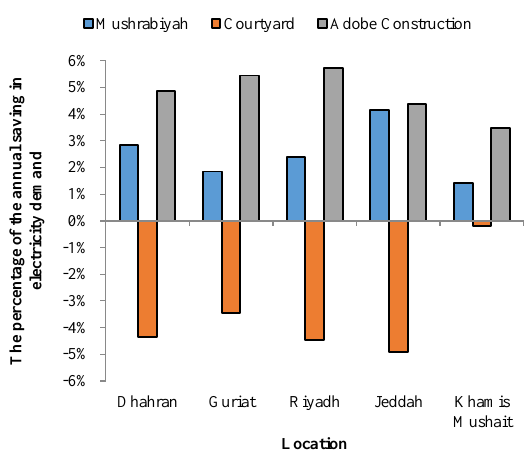
Figure 16. The annually saved electricity by adapting vernacular techniques and adobe construction in all locations. Table 7. The annual peak power demand in W/m 2 .